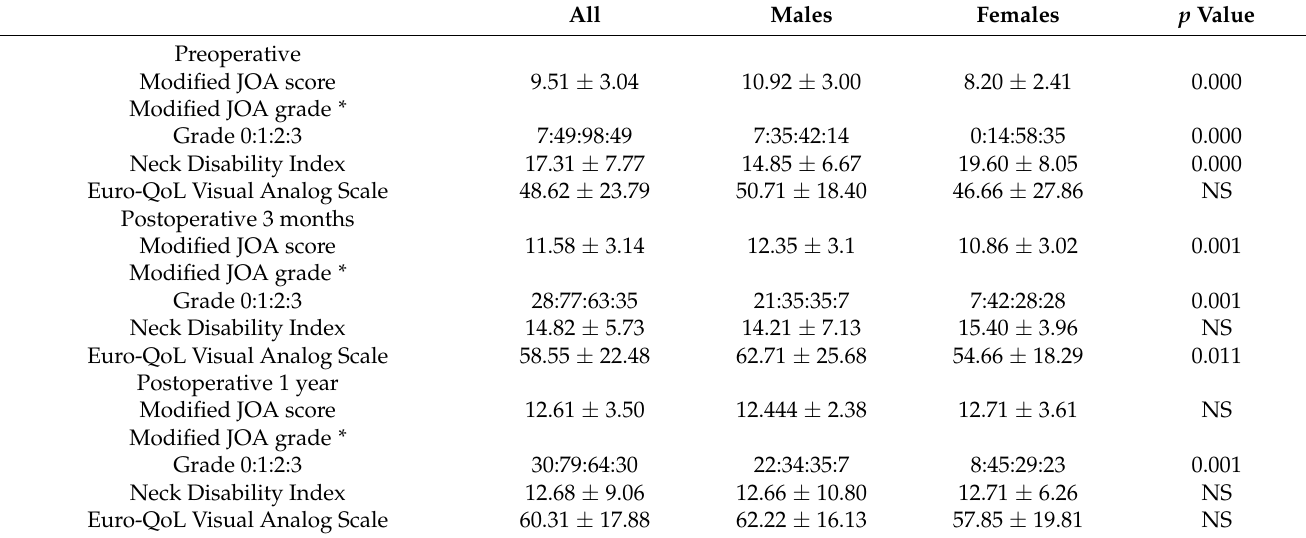
Table 3. Comparison of functional test results between male and female patients. All Males Females p